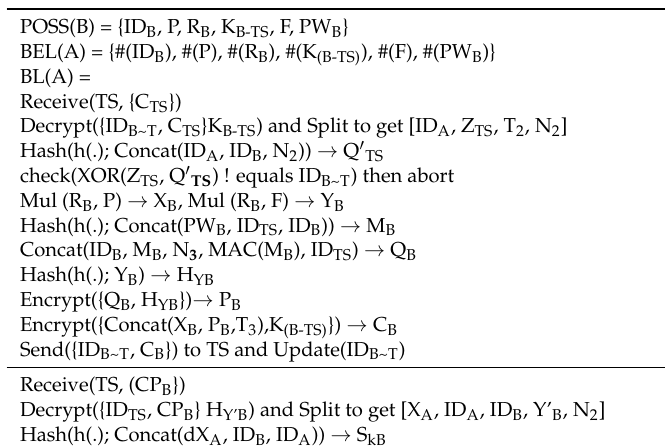
Table 4. Local set at Patient/Doctor